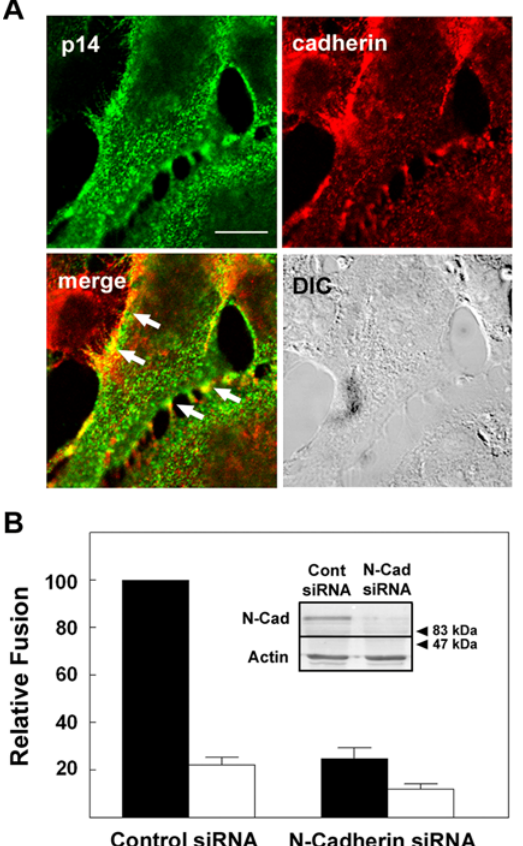
Figure 4. Ablating cadherin expression inhibits p14-mediated syncytiogenesis. (A) Transfected QM5 cells were surface immuno- stained for p14 (green), then permeabilized and immunostained for N- cadherin (red) at 4 h post-transfection. Arrows in the merged image point to regions of N-cadherin and p14 co-localization at cell–cell contacts as indicated by the yellow pixels. The differential interference microscopy (DIC) image of the same field is shown. Scale bar=10 m m. (B) HT-1080 cells were transfected with control siRNA or siRNA directed against human N-cadherin, then co-transfected with p14 and cultured under normal (black bars) or low (white bars) calcium conditions. Cells were fixed at 9 h post p14-transfection and syncytiogenesis was quantified by syncytial indexing. Data is presented as the extent of fusion relative to control siRNA-transfected cells cultured under normal calcium conditions. Values represent the mean 6 S.E. (n=4). The average number of syncytial nuclei per field under normal calcium levels (i.e. the 100% level) was 53.8. The inset shows Western blot analysis of N- cadherin (N-Cad) and actin expression in the cells transfected with control (Cont) or N-cadherin (N-Cad) siRNA. Numbers indicate the mobilities of M r standards.